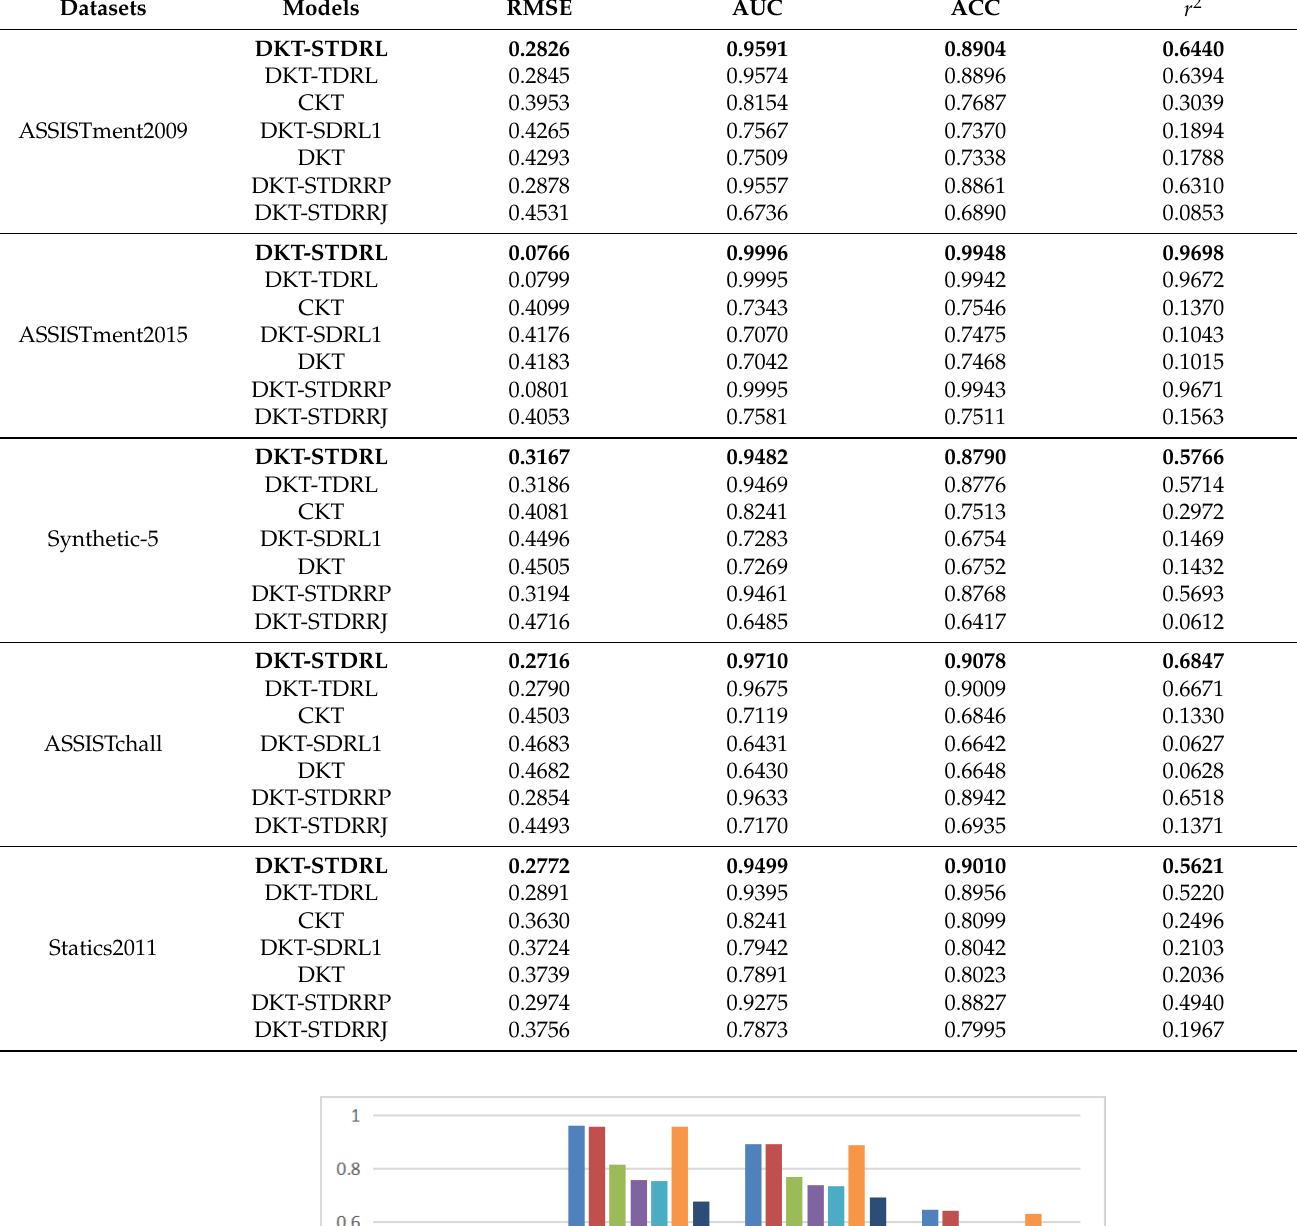
Table 6. Comparison of experimentation results among the DKT-STDRL, CKT, DKT, and variants of DKT-STDRL.